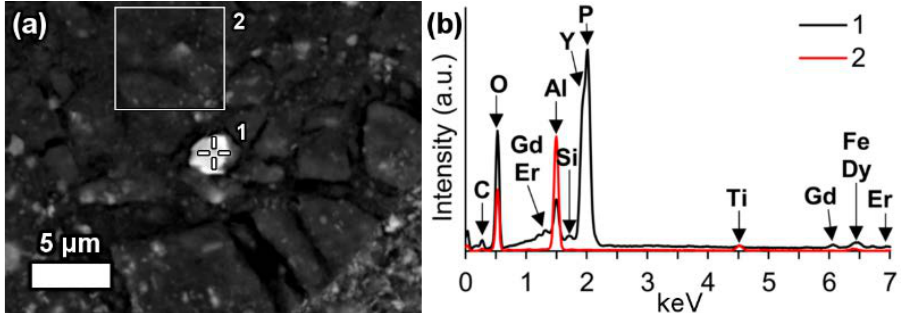
Figure 15. Xenotime or churchite in undigested diaspore/boehmite matrix, depicted on ( a ) backscattered electron image with its ( b ) EDS spectrum.